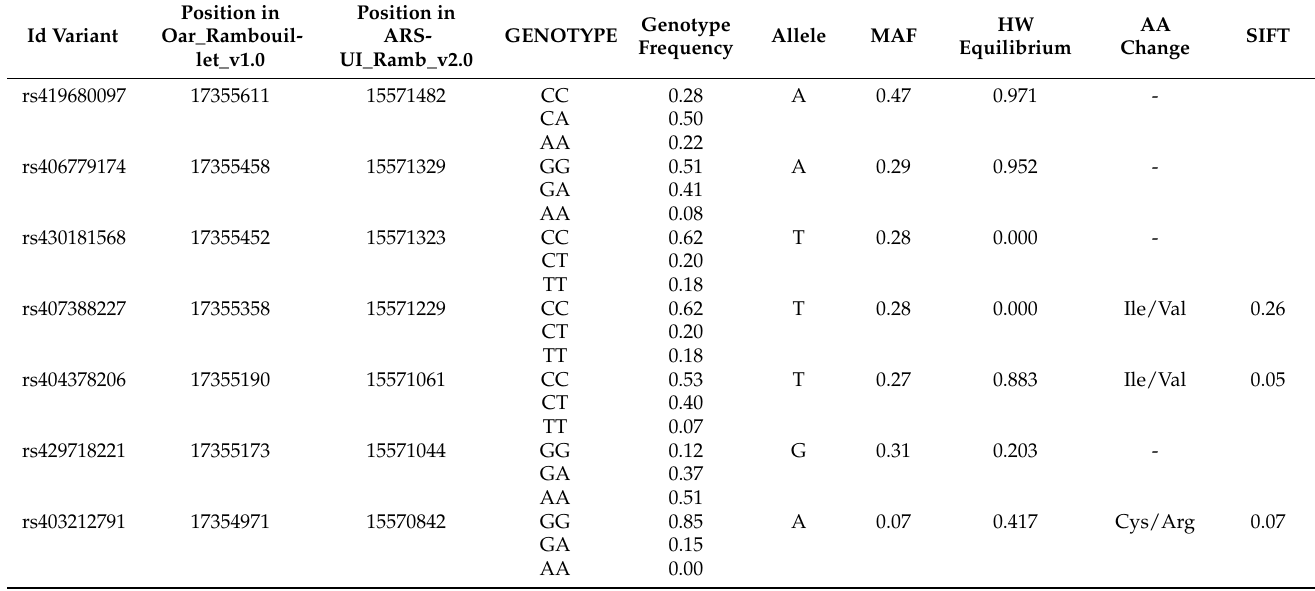
Table 2. Identification code of the variant, position in the current assembly, genotypes, genotype frequencies in all the 800 animals, minor allelic frequency (MAF), Hardy–Weinberg equilibrium, amino acid changes and SIFT (Sorting Intolerant From Tolerant) score (prediction of the effect of an amino acid change on protein